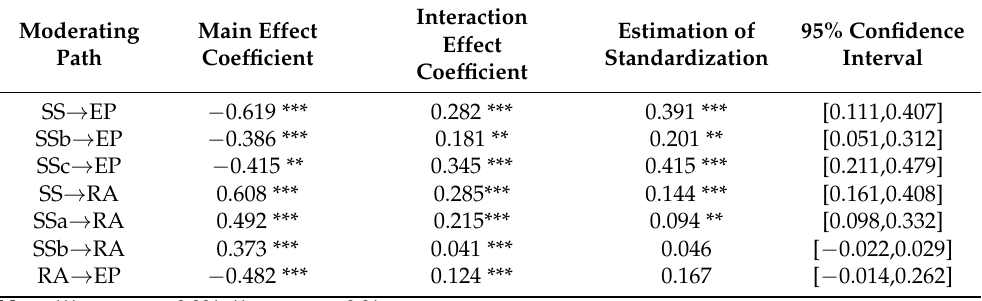
Table 6. Moderating effect.